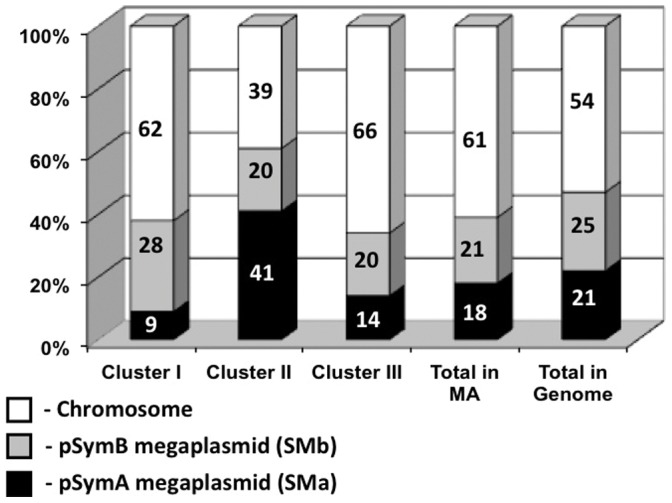
Distribution of differentially expressed genes in S. meliloti Rm1021 replicons.Cluster I. Genes upregulated under nitrogen limitation (97); Cluster II. Genes downregulated under nitrogen limitation (78); Cluster III. genes with expression affected by GlnD/GlnBK regulatory cascade but not differentially expressed under high vs. low nitrogen (442). Total in MA (microarray). The distribution of the 609 genes found to have differential regulation in response to nitrogen stress or mutations in glnD or glnBglnK, as described in the text. Total in Genome. Distribution of annotated genes on pSymA, pSymB or the chromosome.